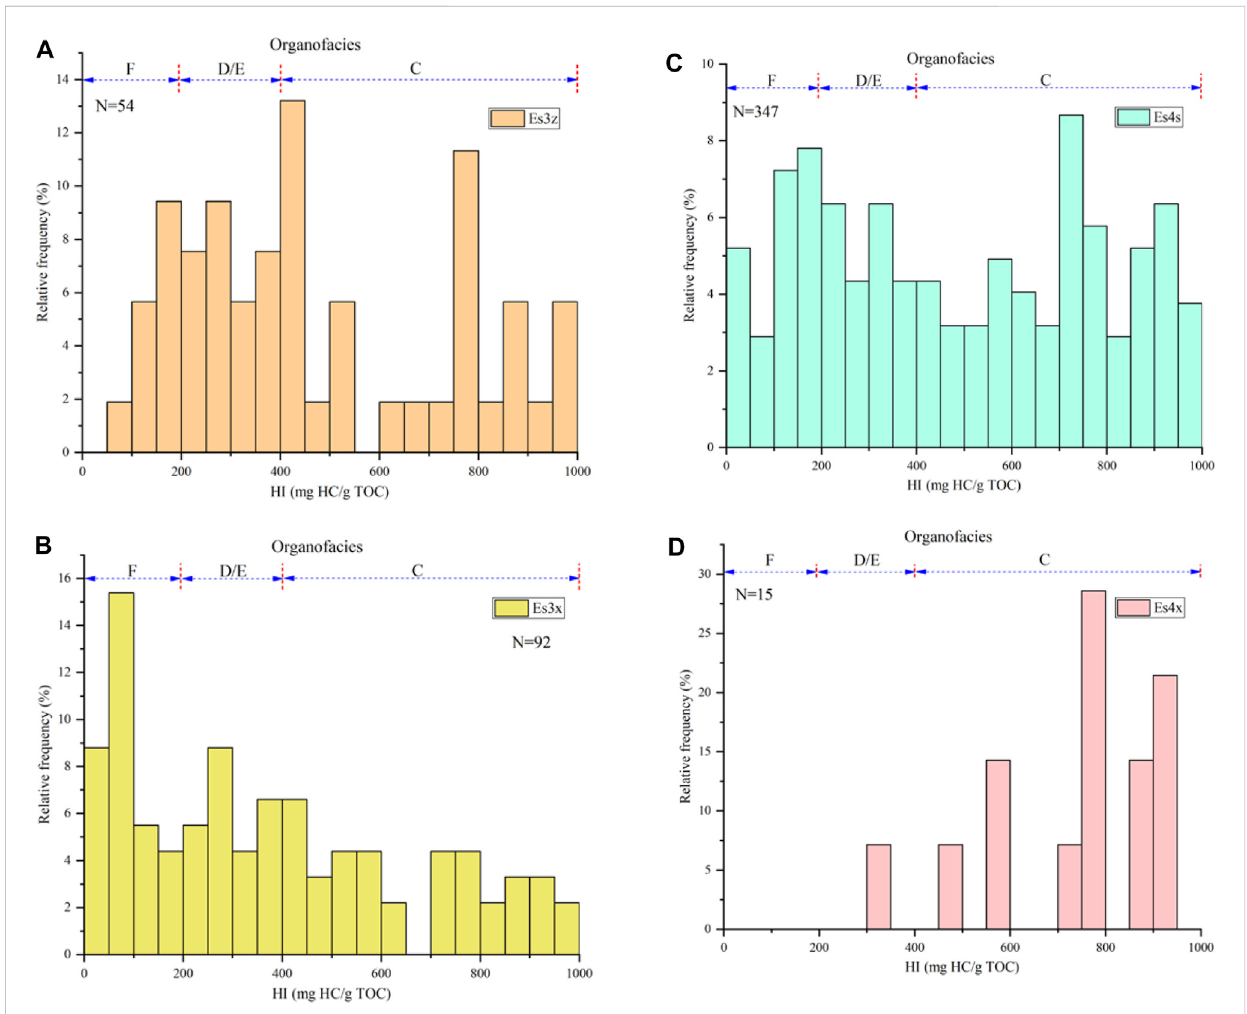
FIGURE 12 Relative frequency distribution histogram of HI for source rocks in different members. (A) Es3z member; (B) Es3x member; (C) Es4s member; (D) Es4x member.